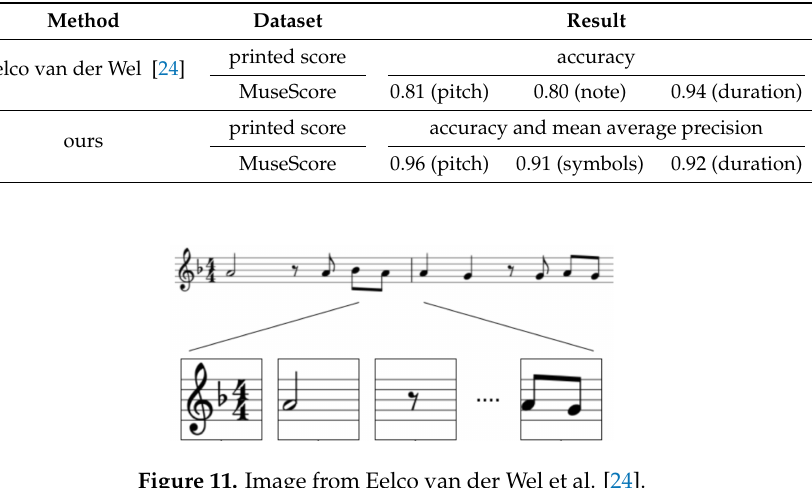
Figure 11. Image from Eelco van der Wel et al. [24].